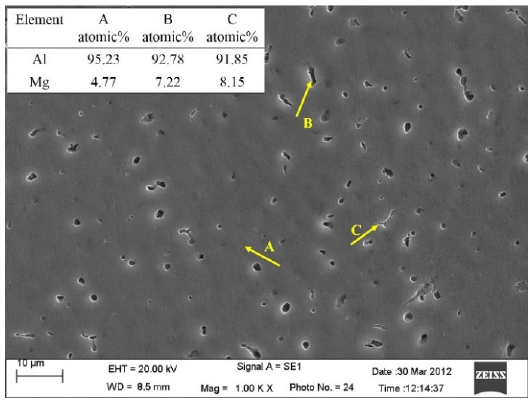
Figure 11. Microstructure of weld zone with energy dispersive spectrometer ( EDS) analysis.